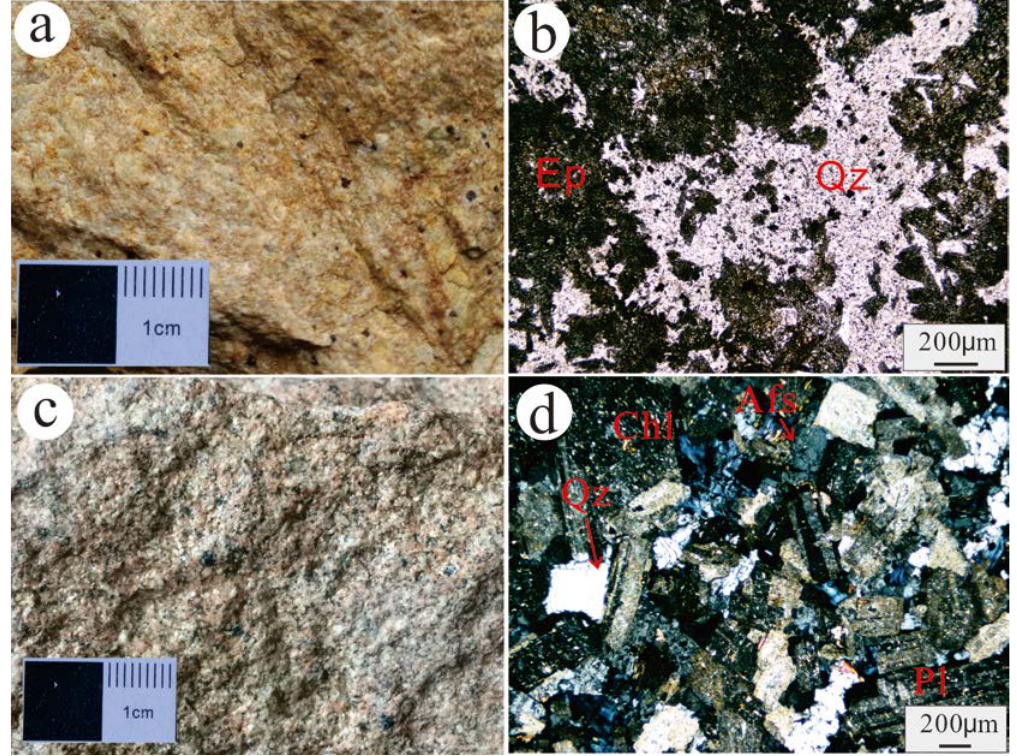
Figure 3. Representative photographs of the intrusions in hand specimen and thin-section. ( a , b) Granodiorite from the Tonggou deposit; ( c , d ) granodiorite from the Daheyan area.